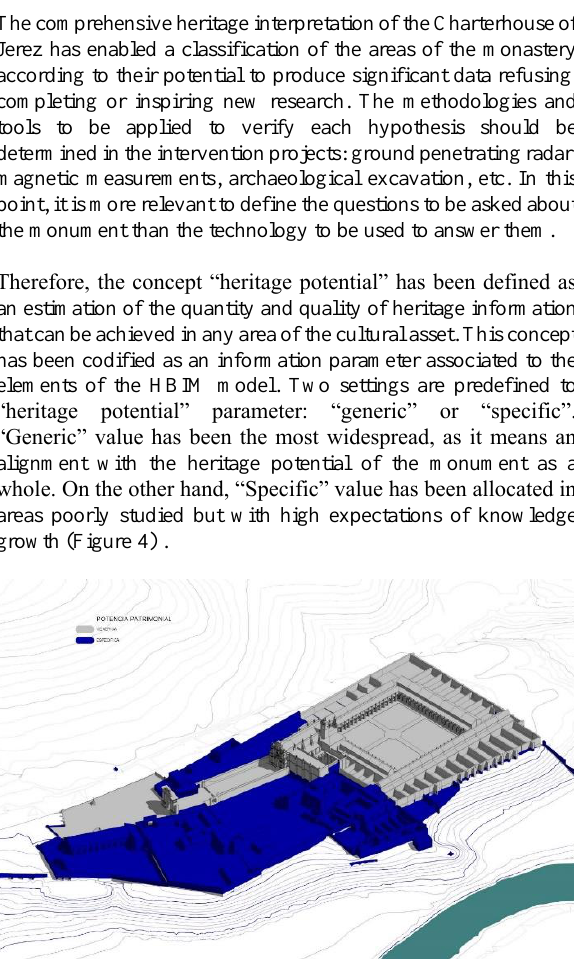
Figure 4: Heritage Potential view. HBIM Charterhouse of Jerez, phase 15, Sisters of Bethlehem (2000-…)